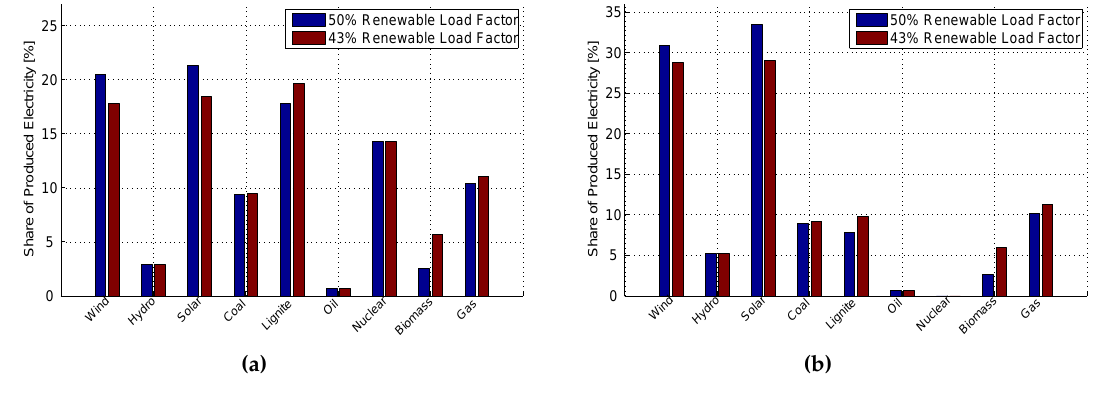
Figure 5. Changes in generation profile when renewables decrease from 50% of total renewables power capacity to 43% at the same time periods in 2013 and 2020. ( a ) 2013; ( b )